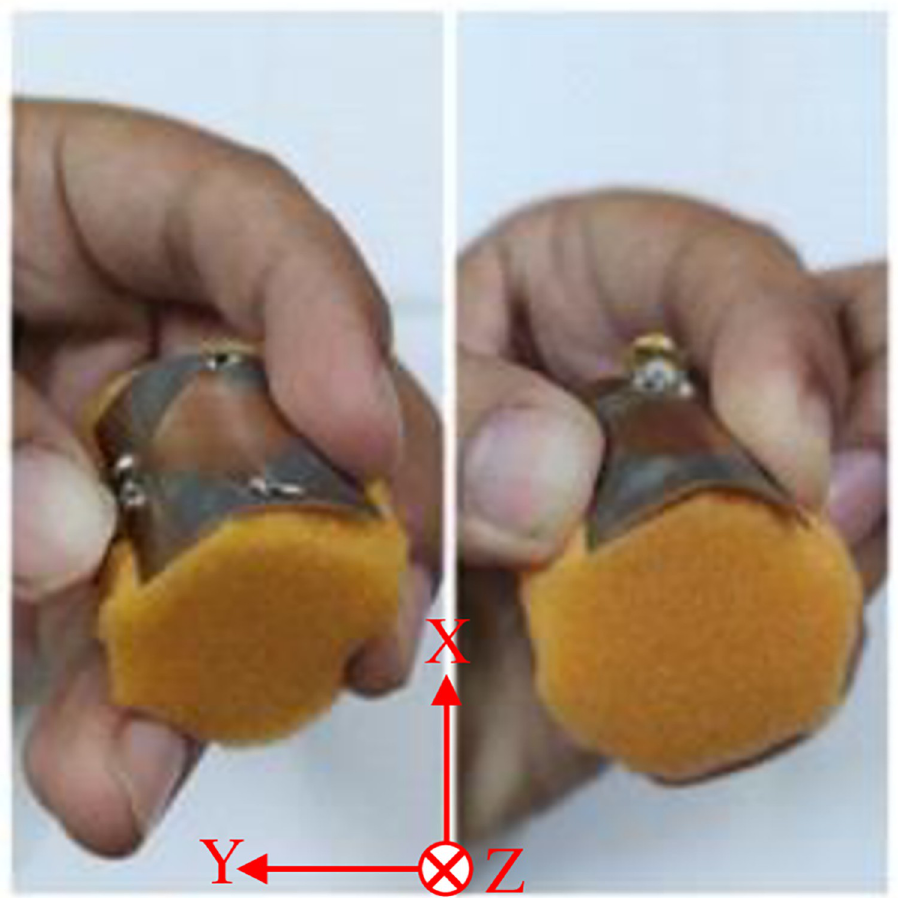
Fig 12. The prototype frequency reconfigurable antenna under the conformal